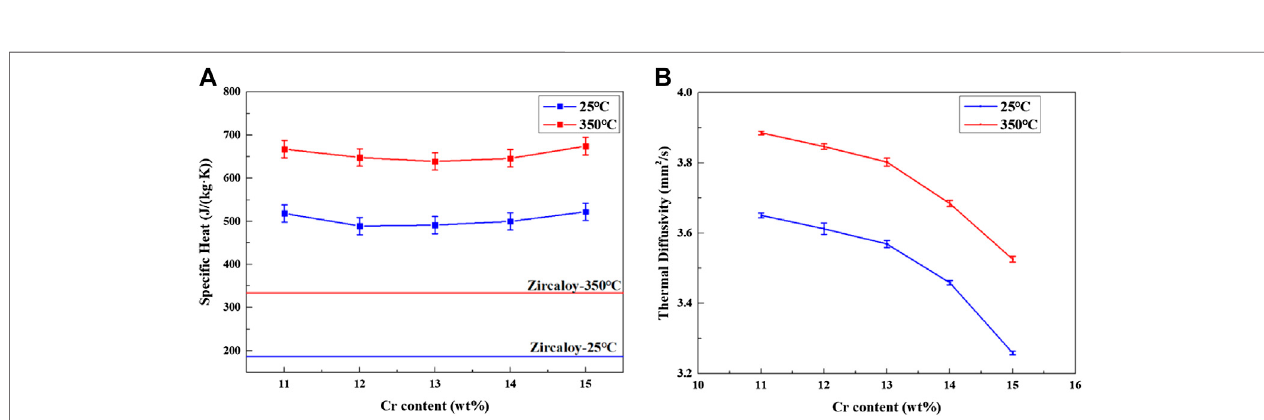
FIGURE 12 | The thermal conductivity (A) and thermal diffusivity (B) of Fe – x Cr – 6Al alloy with different Cr content.